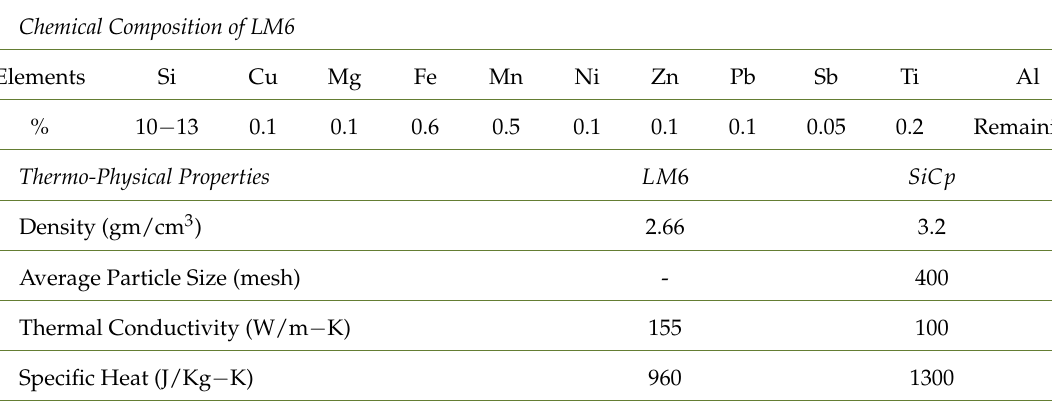
Table 1. Properties of LM6 Aluminium Alloy, SiCp and AMC Preforms.